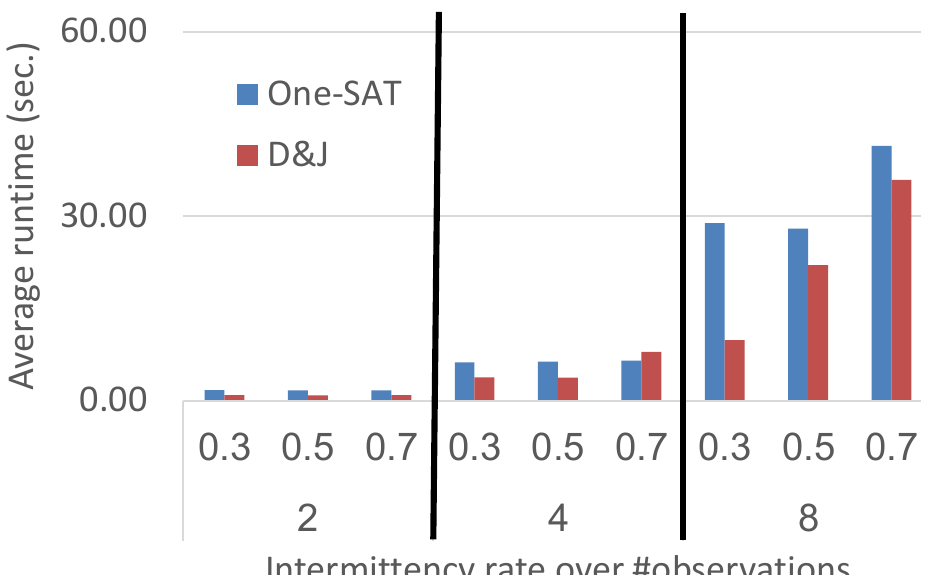
Figure 5. Runtime as a function of the intermittency level ( p int ) and #obs.